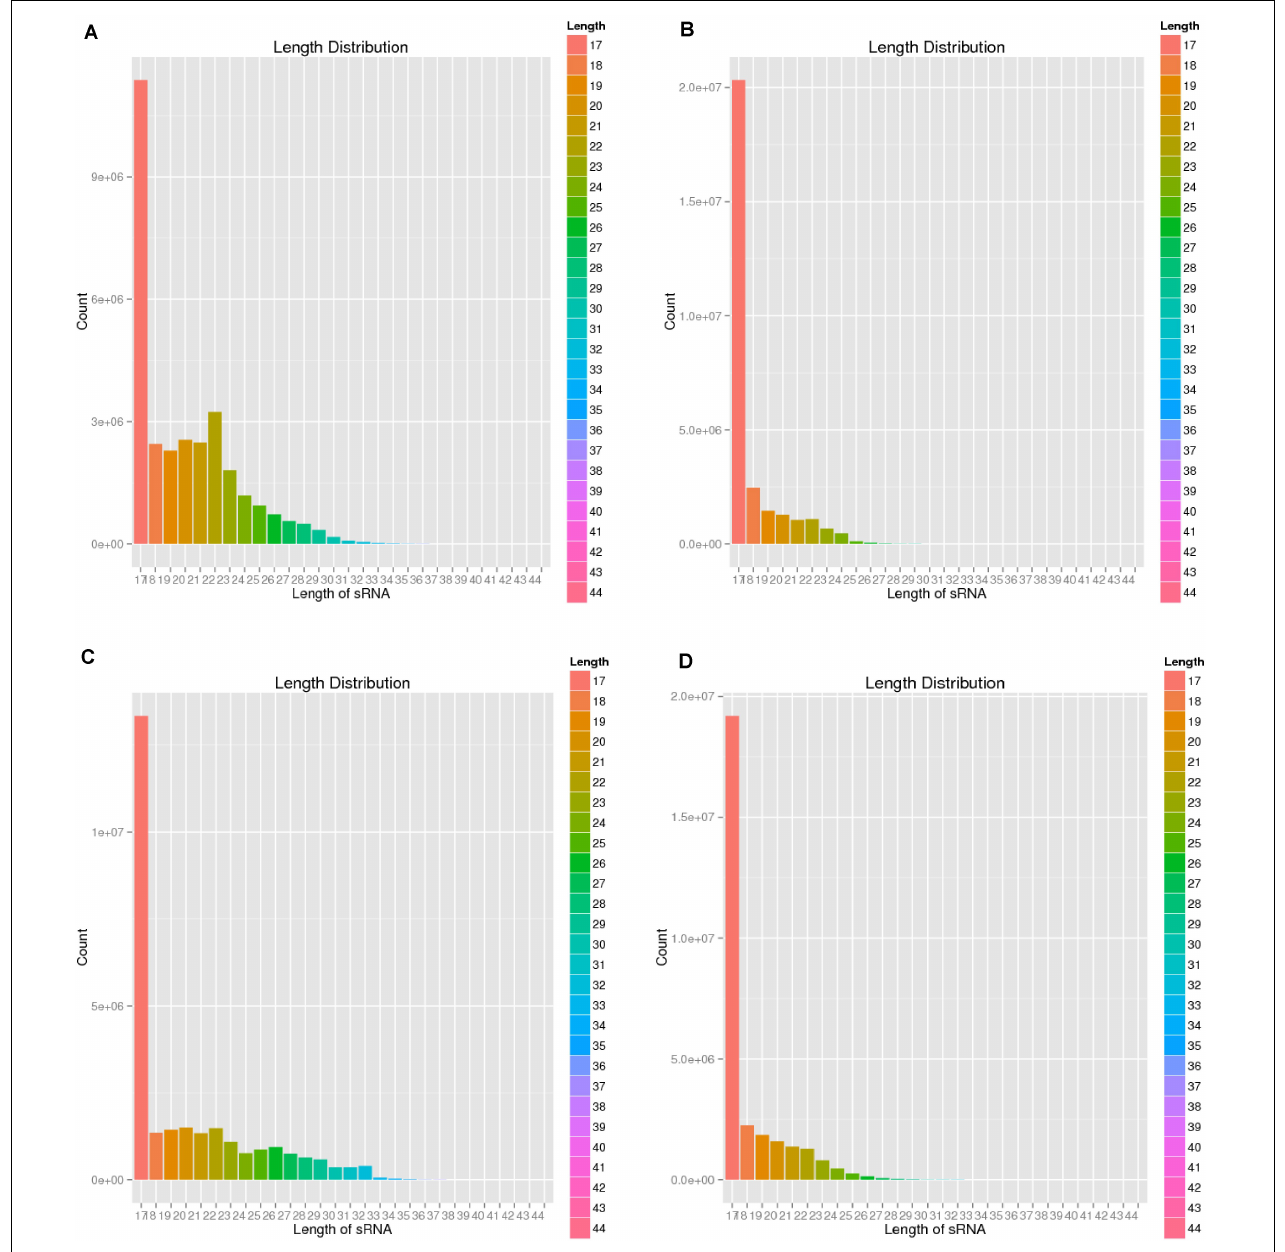
FIGURE 2 | Length distribution of four sequencing results. (A) Negative control group; (B) Positive control group; (C) P-ONE group); (D) P-TWO group. From such four bar plots, most of the small RNAs have reasonable length less than 18 nt, corresponding with the general distribution of small RNAs’ length. Therefore, such results validated the high-quality of our sequencing and the accurate identification of small